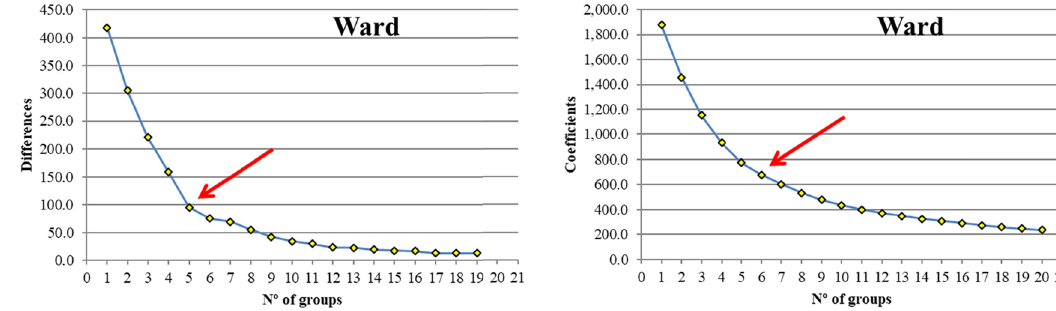
Figure 3: Agglomeration schedule with ward ’ s method to fi x the number of